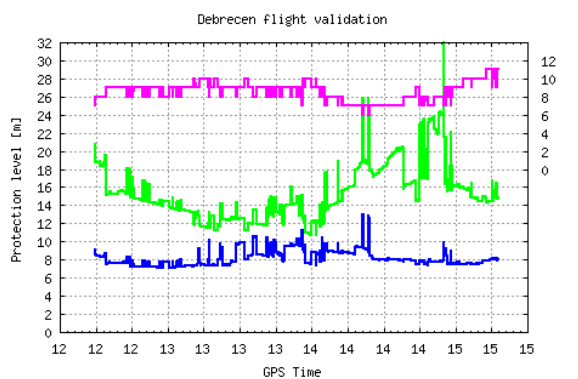
Figure 7. Protection level calculated by RTKLIB during the flight trial. Measurements recorded by the onboard receiver.